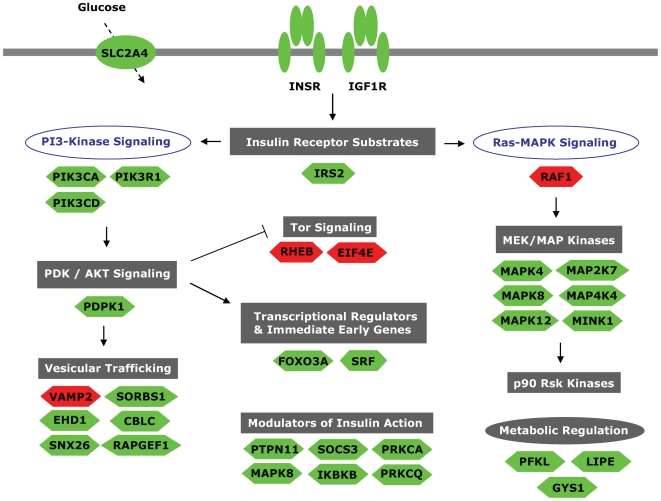
Regulation of insulin signaling in people with type 2 diabetes.The insulin signaling pathways were found to be significantly downregulated on the gene expression level using the program GenMAPP/MAPPFinder. Analysis criteria were set as described in the Methods section. Underneath each section of the pathway, genes found to have an increased expression are depicted in red, and genes found to have a decreased expression are depicted in green. Figure adapted from GenMAPP.